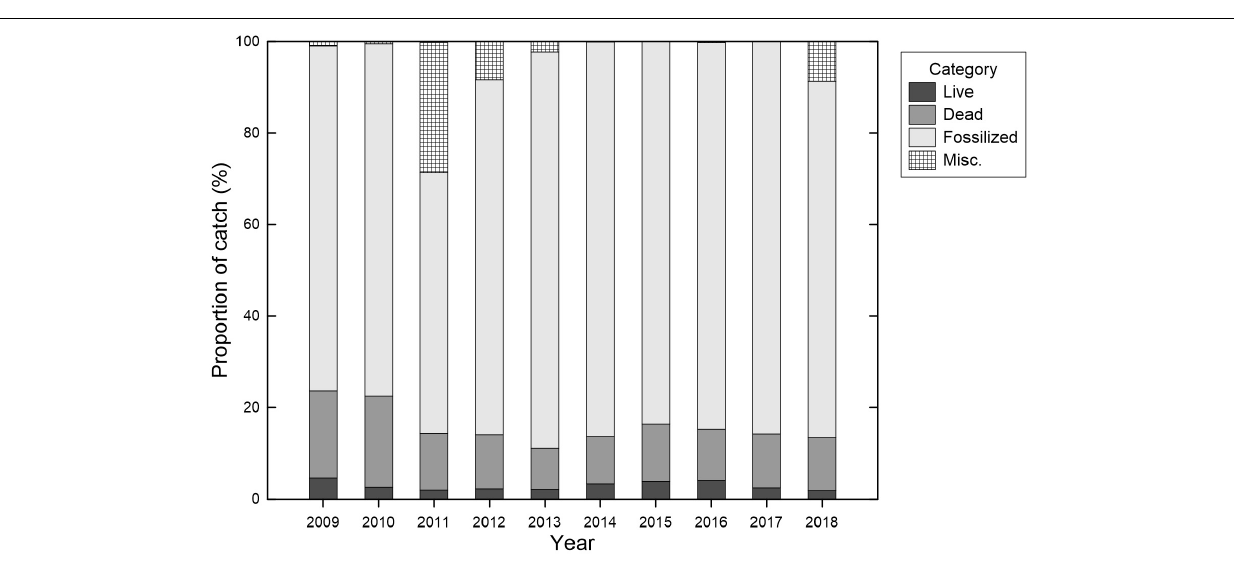
FIGURE 3 | Annual proportion (%) of the total catches categorized by the commercial category (live, dead, fossilized colonies, or miscellaneous) of precious corals of the Taiwanese precious coral fishery between 2009 and